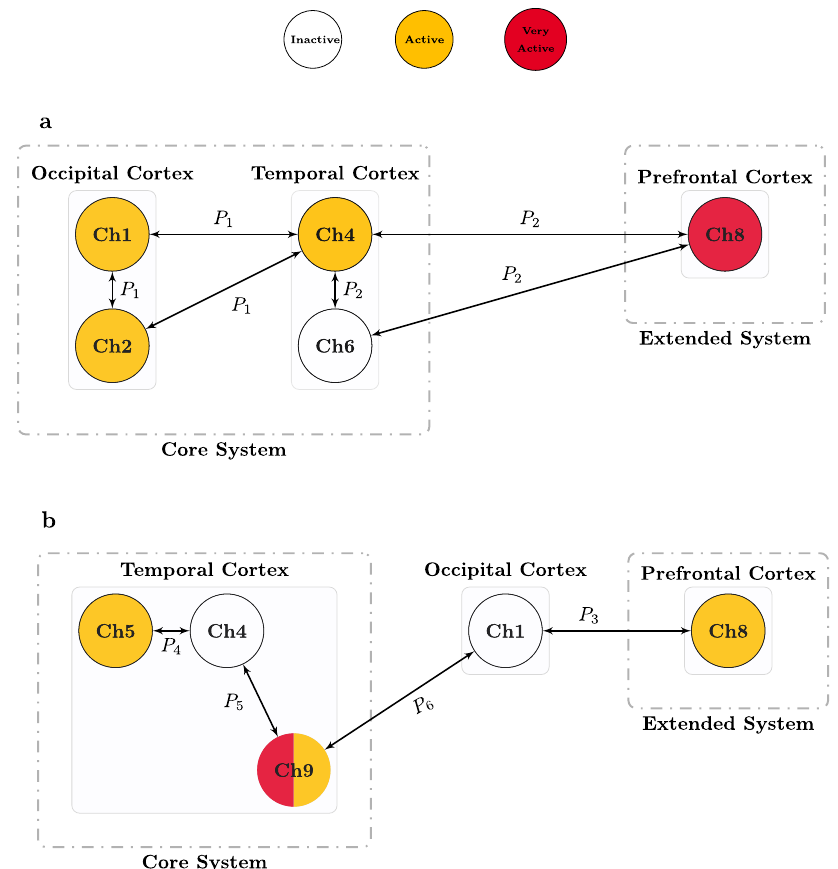
Fig. 4 Illustration of cortical networks proposed by xMVPA. a A model for face processing in 6-month-old infants, based on the patterns P 1 and P 2 revealed by the xMVPA inference mechanism. The proposed model consists of an occipital-temporal network as a core system that undertakes the primary processing of facial features (two eyes above a nose above a mouth), and of the prefrontal cortex as an extended system that processes the emotion associated with the visual stimulus (i.e., associate happiness with a smiley face). b A model for non-speech auditory processing in 6-month-old infants, based on the patterns P 3 to P 6 revealed by the xMVPA inference mechanism. The proposed model consists of the temporal cortex as a core system for processing non-speech auditory stimuli, and of the prefrontal cortex as an extended system that processes the emotion associated with the auditory stimulus. The colour of the channel ’ s (Ch) circle is based on its activity level: inactive (white), active (amber), and very active